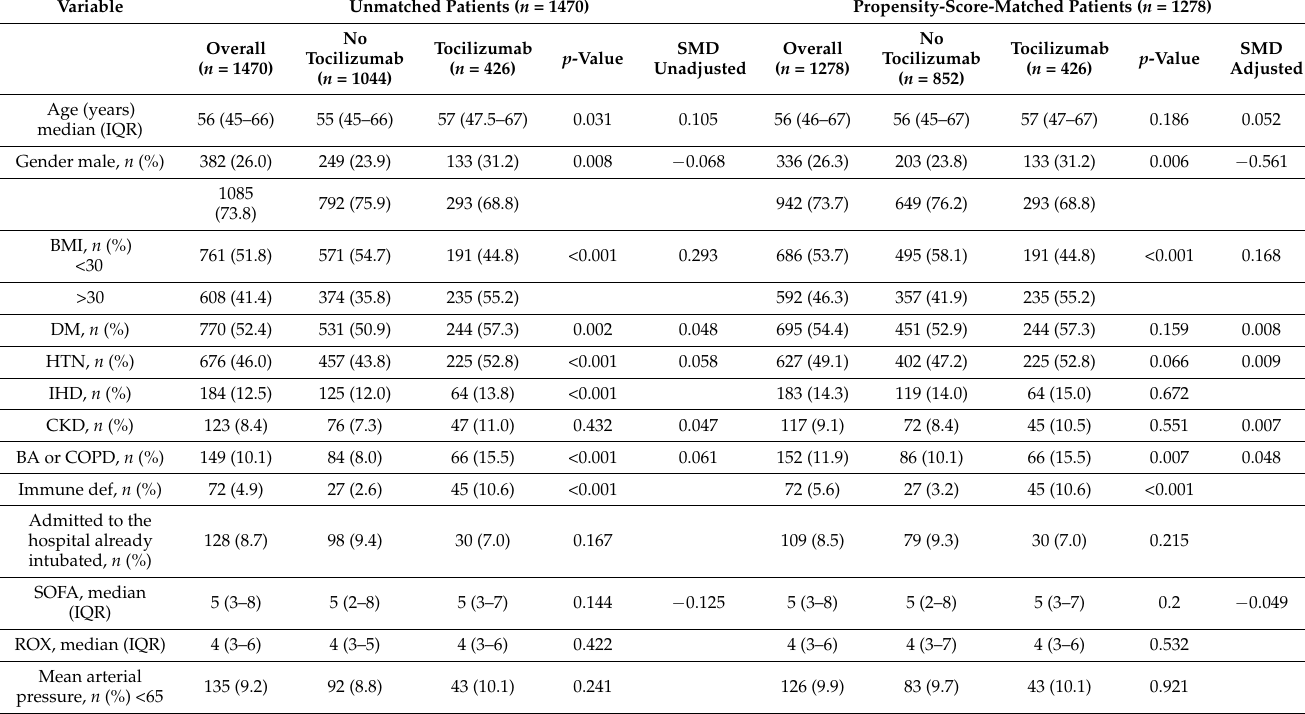
Table 1. Characteristics, demographics, and combined interventions of tocilizumab and non- tocilizumab